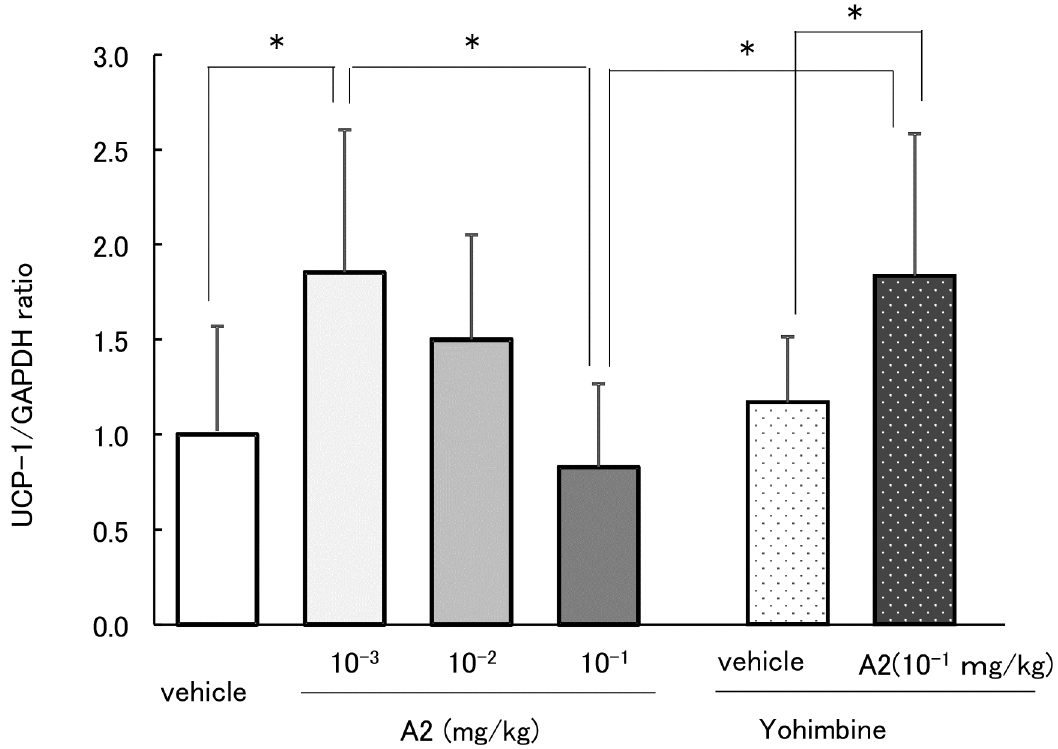
Fig 4. Dose-reactive response of UCP-1 mRNA levels to A2 and A2 plus yohimbine in BAT. The values represent mean ± standard deviation (each group, n = 8). (cid:3) p < 0.05, (cid:3)(cid:3) p < 0.01 (Tukey-Kramer test between experimental group).